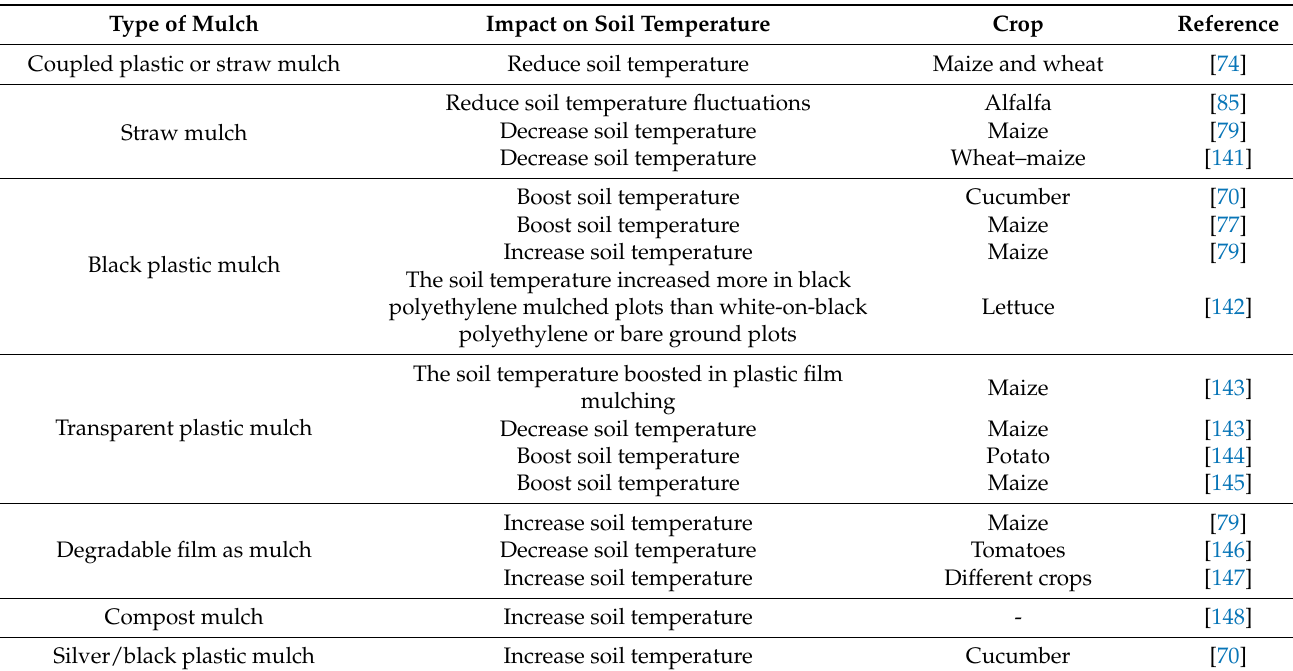
Table 3. Impact of various mulch types on the soil temperature in different